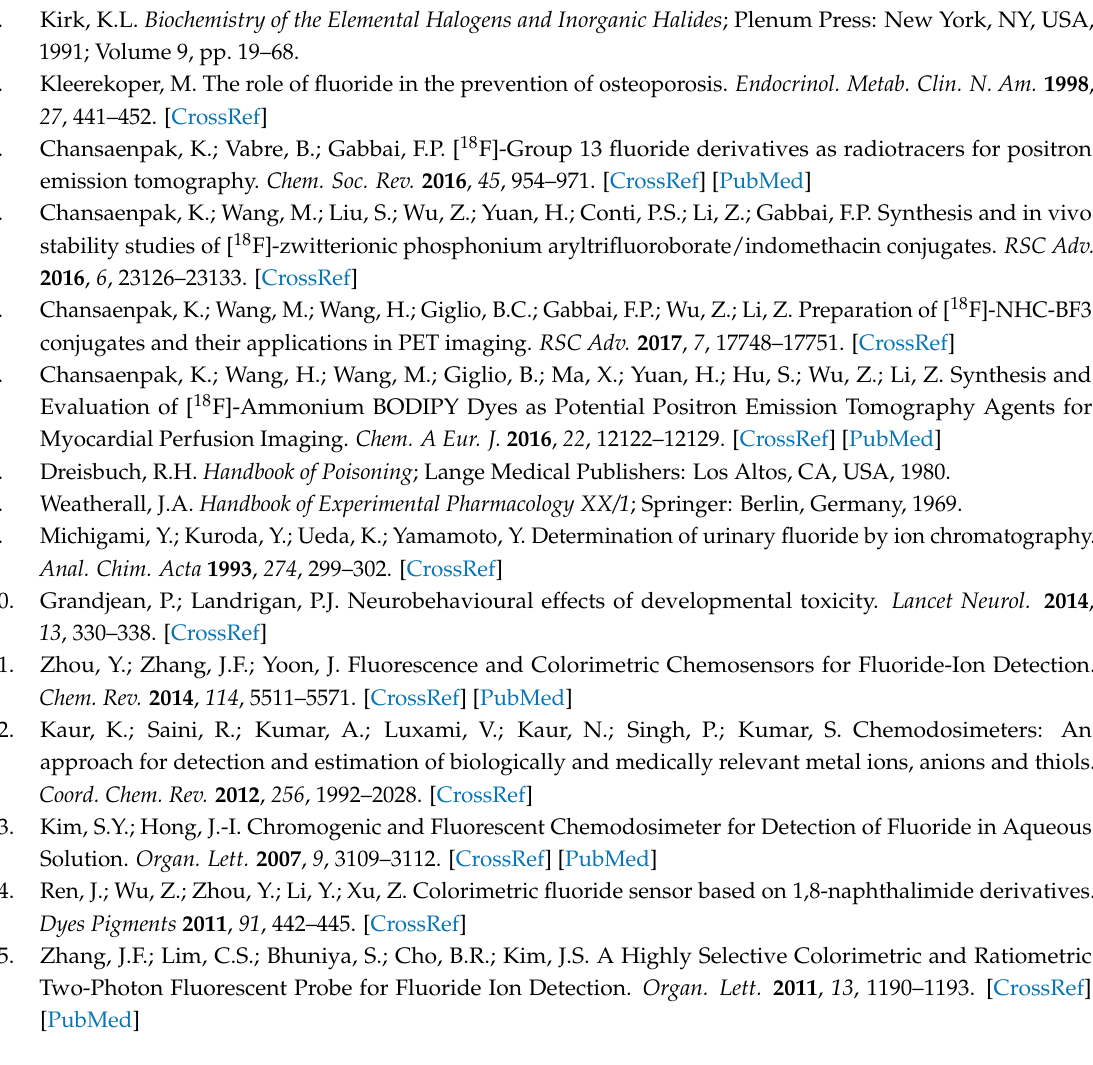
Table S1. Kinetic data for the hydrolysis of 2 , Table S2. Kinetic data for the hydrolysis of 3 , Table S3. Kinetic data for the hydrolysis of 4 , Table S4. Kinetic data for the hydrolysis of 5